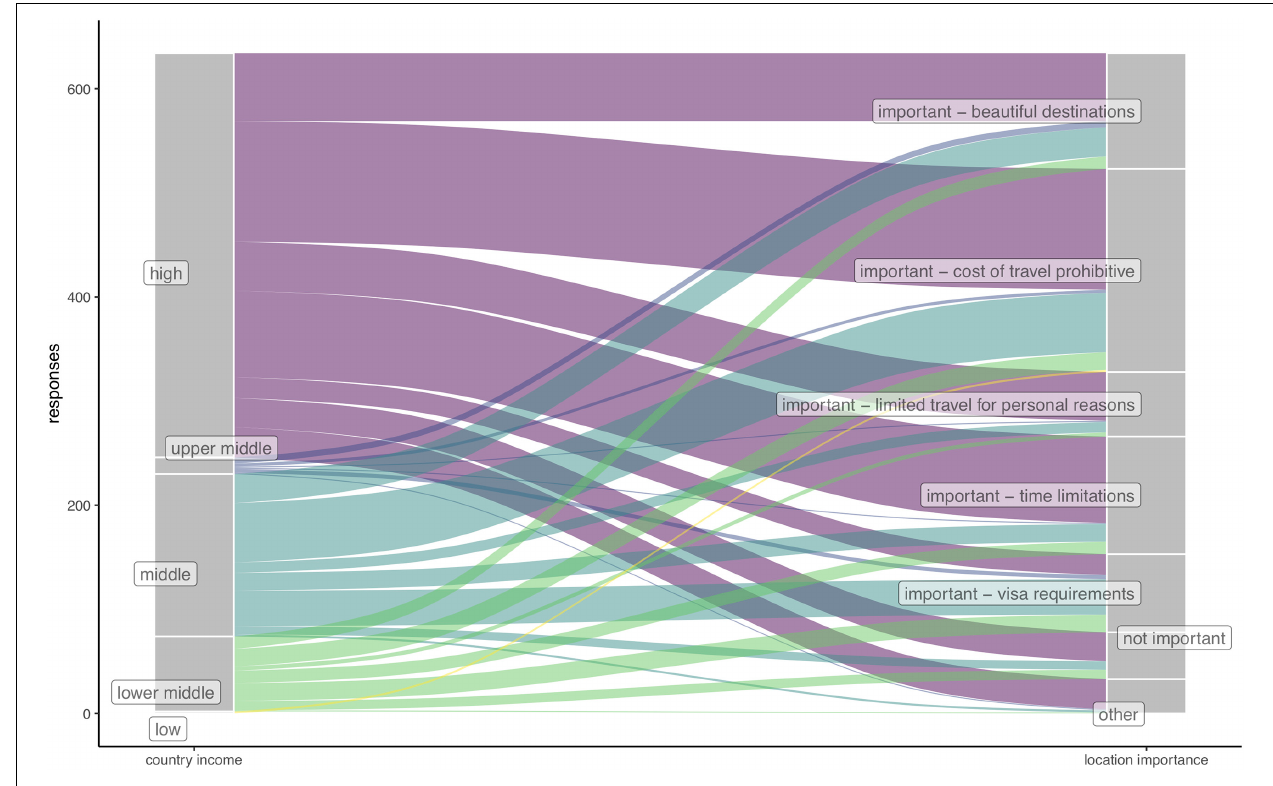
FIGURE 6 | Comparison of the income of the country of residence of respondents, from the World Bank definitions (World Bank, 2019), and the importance of future conference location. Respondents could choose multiple options.